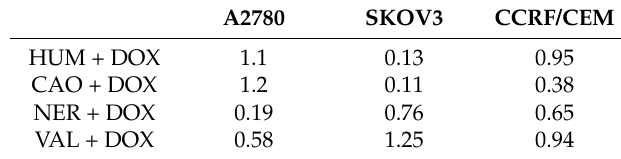
Figure 3. Combination indexes (CI) of DOX and sesquiterpenes in dependence of the fraction of affected cells (Fa) in ovarian cancer cell lines A2780 ( a ) and SKOV3 ( b ) and lymphoblast cell line CCRF/CEM ( c ). Incubations lasted for 72 h. Data were calculated using CalcuSyn software. Table 2. Overview of CI of DOX and sesquiterpenes in Fa = 0.8 calculated by CalcuSyn software.